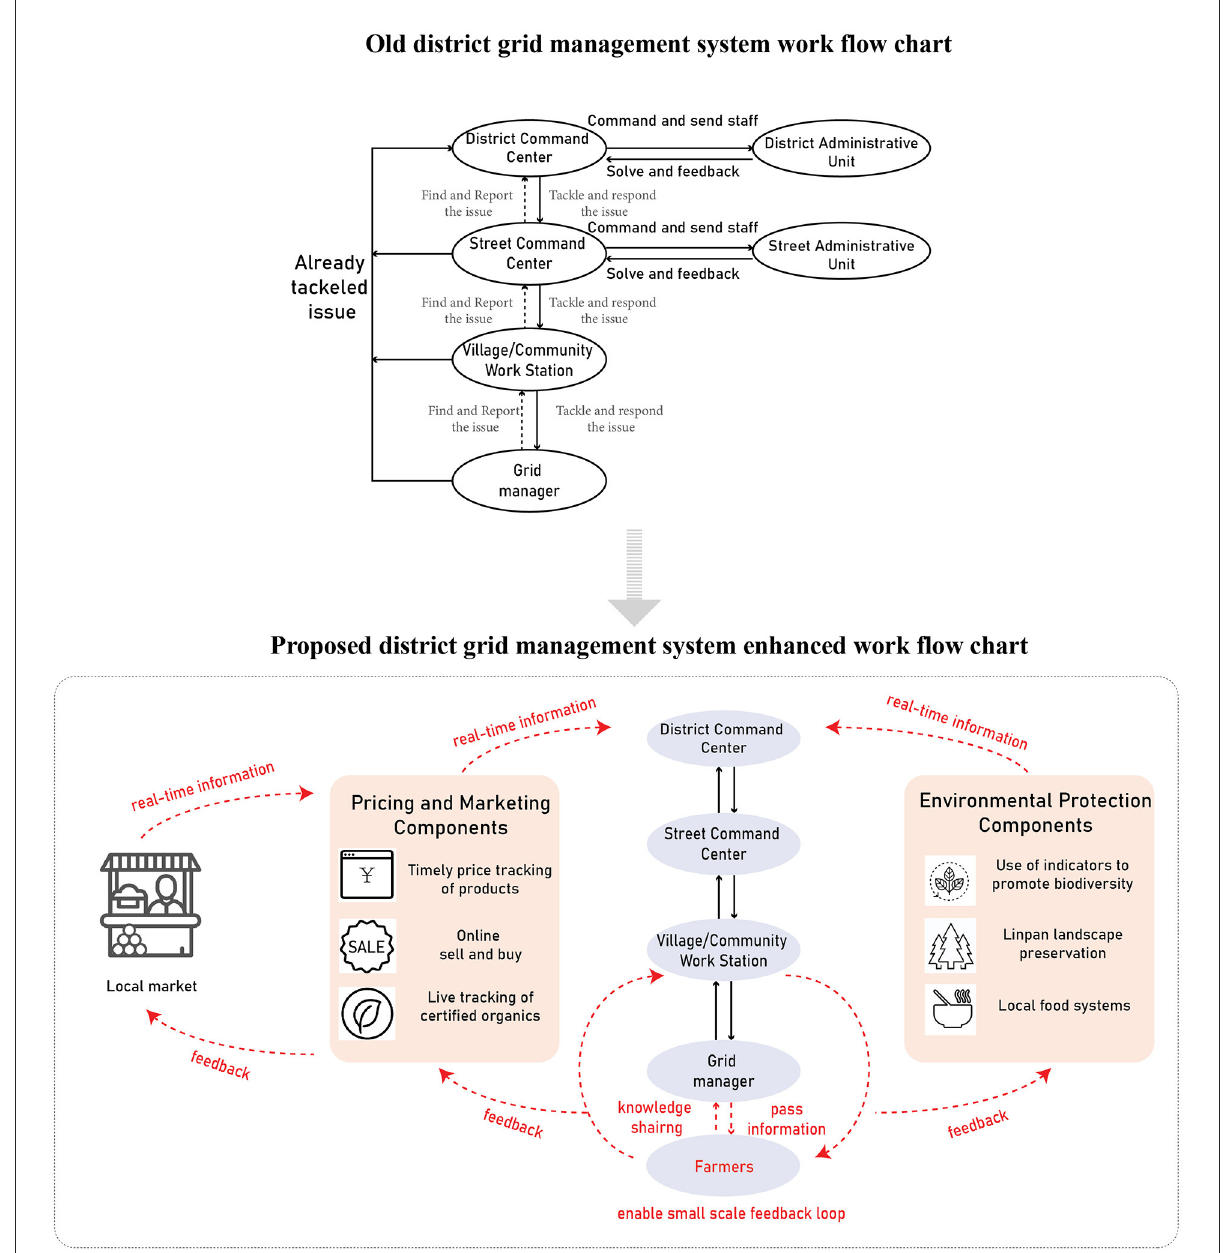
FIGURE5 The proposed enhanced feedback loop. The proposed feedback loop could enable the big data gathered from the web to be passed through this net down to the lowest level. Grid managers, in this case, function as an important linkage between the ICT system and the vulnerable groups (e.g., elder farmers). They could deliver the message through personal interaction with local farmers. The old workflow chart is referenced from “Grid Manager Working Manual”, a hard copy provided by Mr.